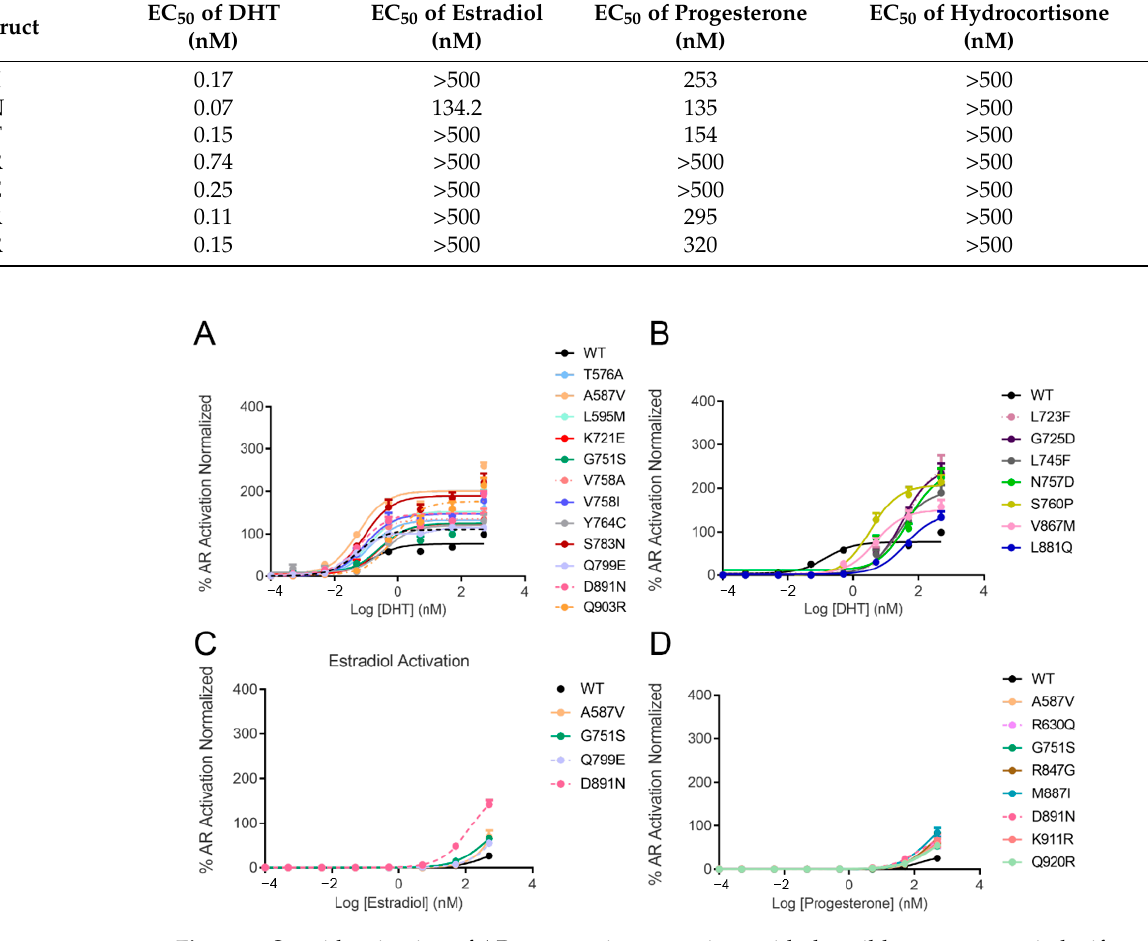
Figure 2. Steroid activation of AR mutants in comparison with the wild-type receptor in luciferase reporter assay. AR mutants that showed similar ( A ) or lower ( B ) affinities to DHT than WT but reached higher activation levels. Mutants that were better activated by estradiol and progesterone, compared to wild-type, are shown in ( C , D ), respectively. None of the mutants were activated by hydrocortisone. The graphs represent the average ± SE of three independent experiments with four replicates each. The activity of each mutant in the presence of a steroid was normalized to the wild type stimulated by 500 nM of DHT. Table 1. The activation of AR mutants by various steroids. The EC50 values of the activation by DHT, estradiol, proges- terone and hydrocortisone are reported for the wild-type AR and the 44 studied mutants. For steroid activation, we tested a concentration range up to 500 nM; therefore, mutants showing no activation or very weak activation in the studied range are presented with EC50 values > 500 nM.